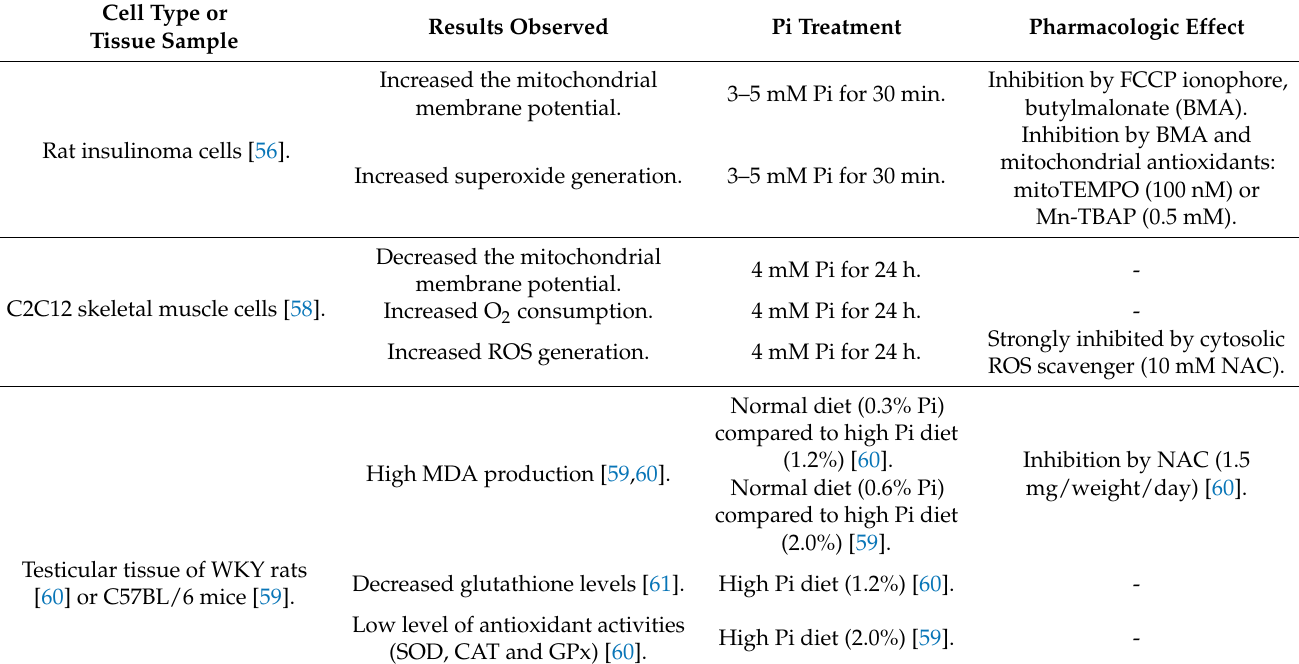
Table 5. Effects of Pi-induced ROS production in different